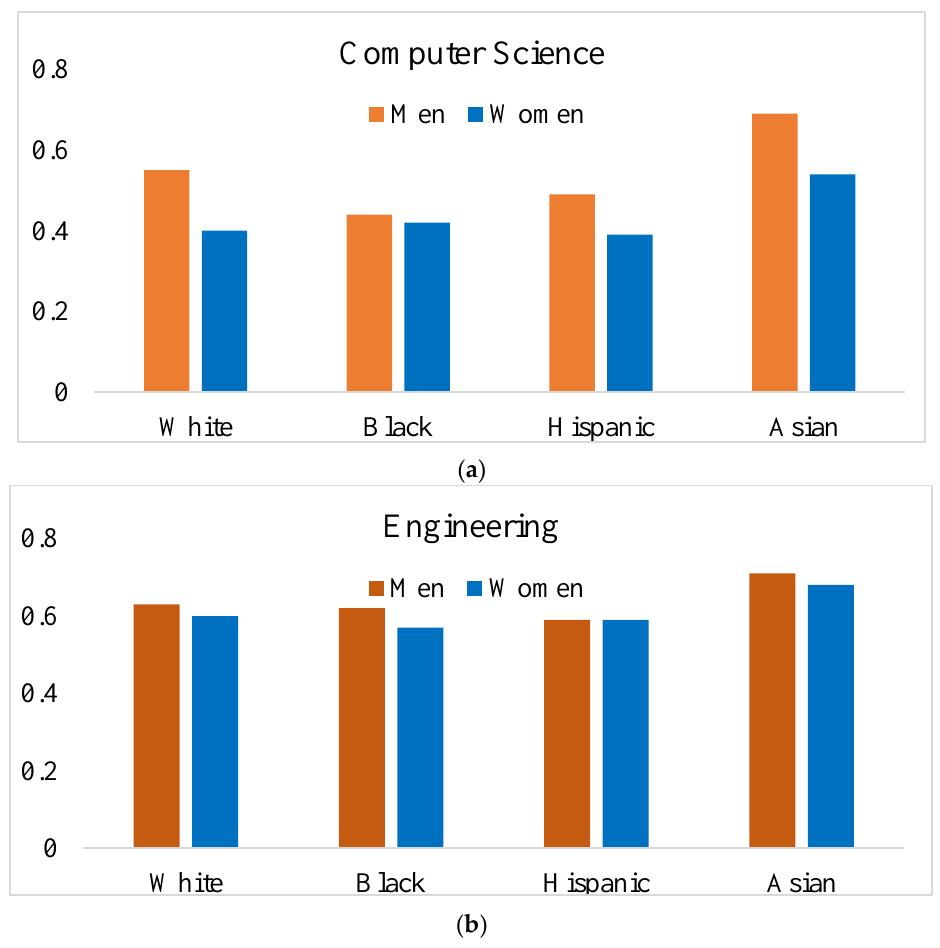
Figure 2. Share of men and women working in STEM among computer science and engineering degree holders, by race. ( a ) Computer Science Majors; ( b ) Engineering Majors. Source: National Science Foundation’s Scientists and Engineers Statistical Data System (SESTAT) 1995–2008. All men and